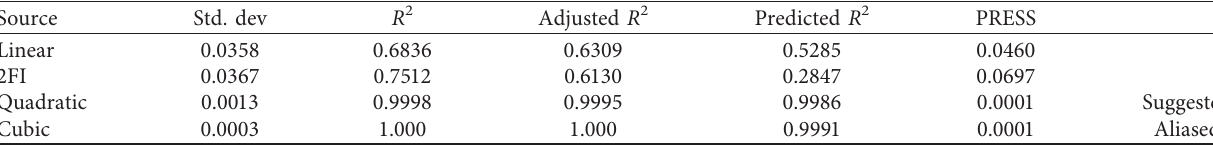
Table 2: Adequacy of tested models for WP as response.